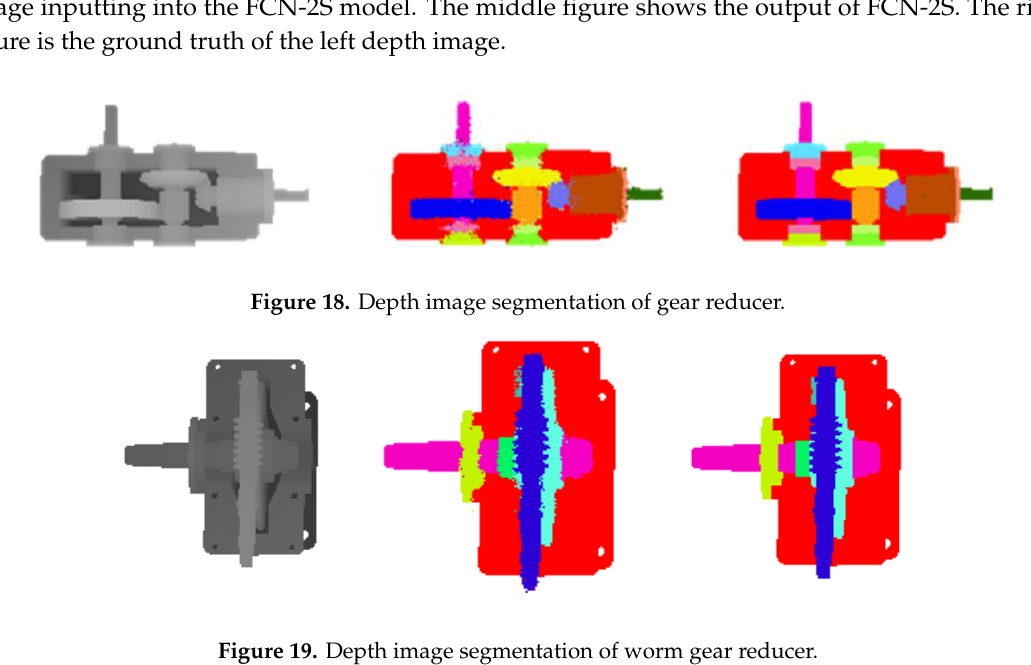
Figure 19. Depth image segmentation of worm gear reducer.